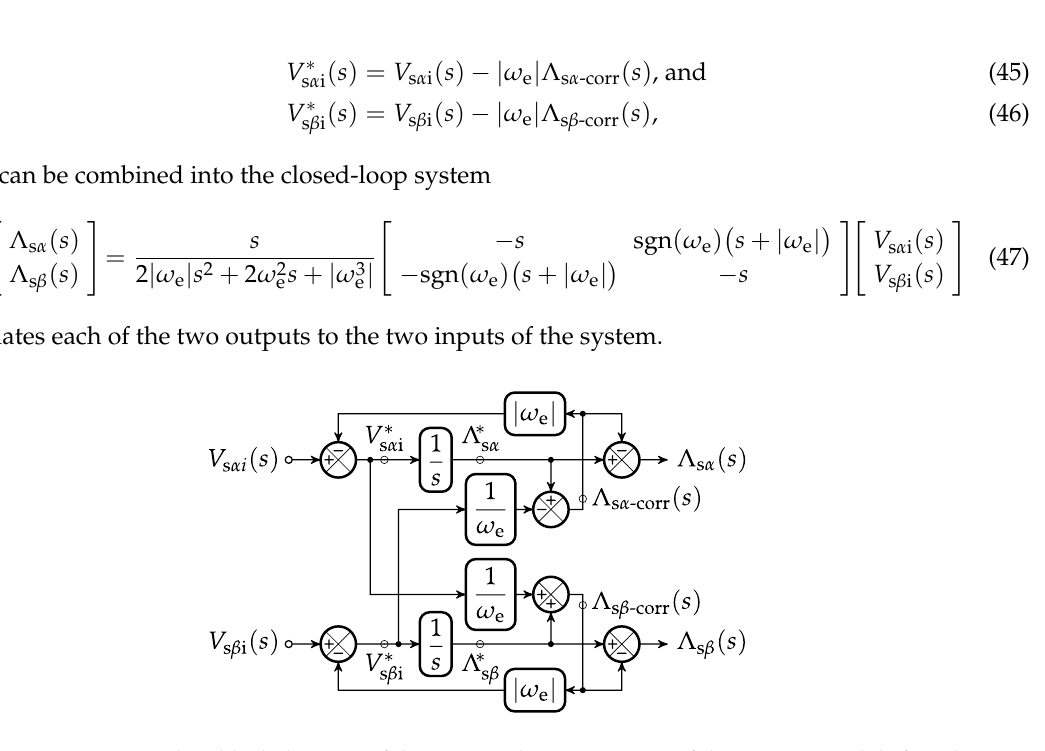
Figure 4. An equivalent block diagram of the proposed compensation of the integrational drift in the Laplace